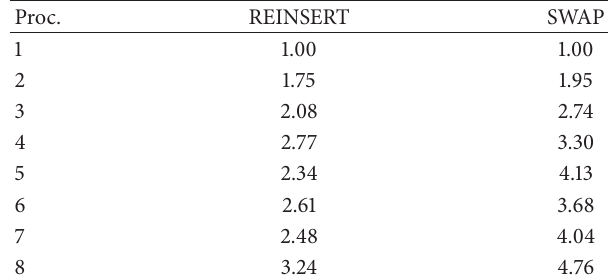
Table 3: DLS speed-up: random start. Proc.